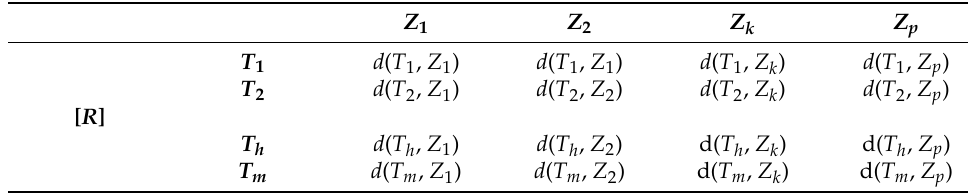
Table 1. Similarity relations between T and Z